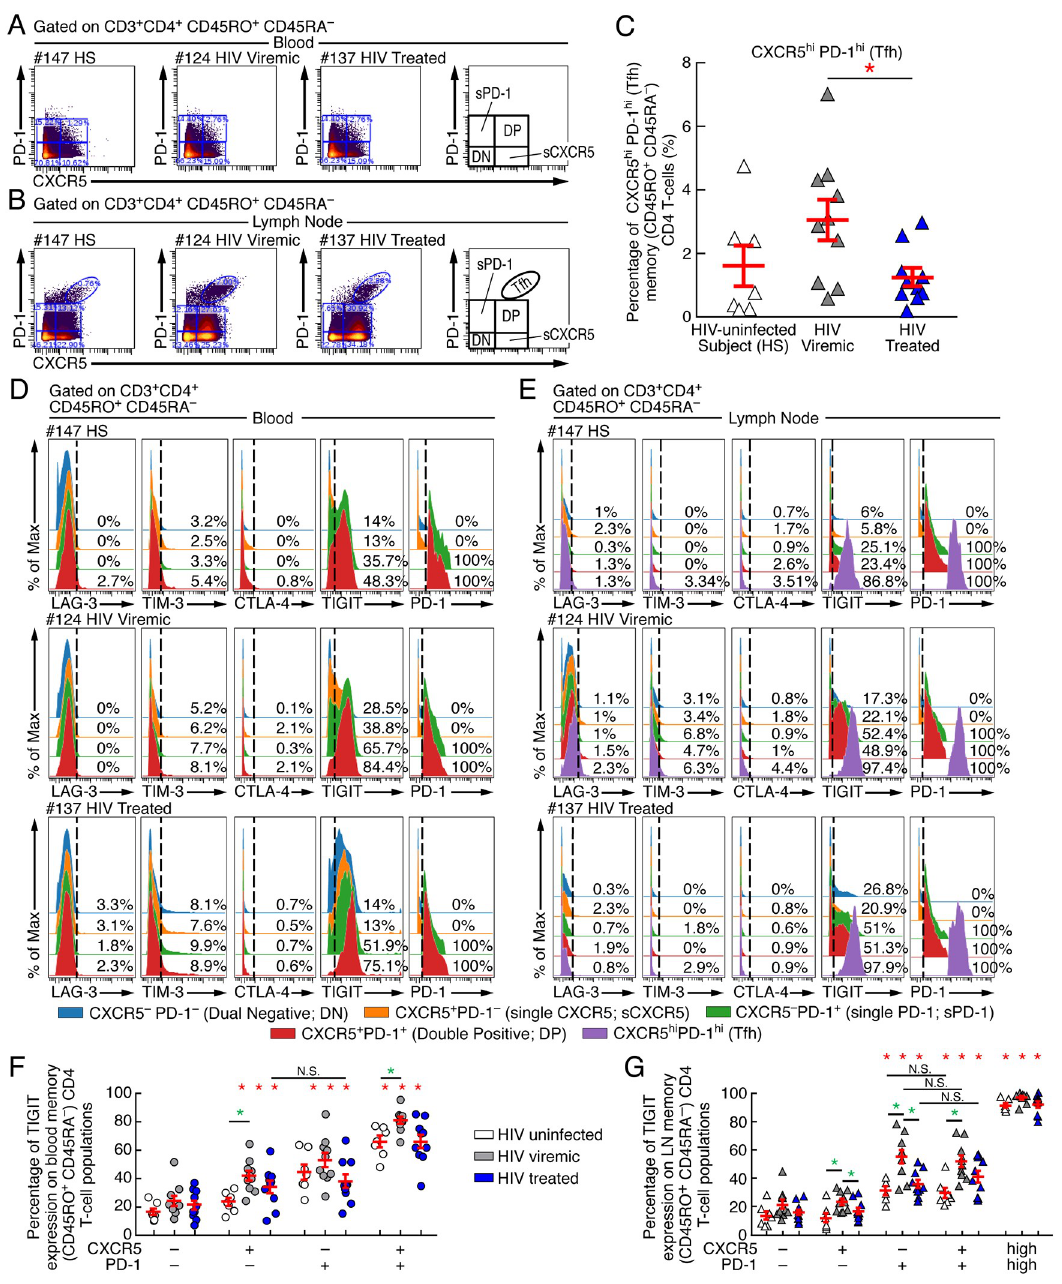
Fig 1. PD-1 and TIGIT are the two major ICs expressed on blood and LN memory CD4 T-cell populations including T- follicular helper cells. Representative mass cytometry profile of blood (A) and LN (B) memory (CD45RA - ) CD4 T-cell populations expressing CXCR5 and/or PD-1 of representative HIV-uninfected (#147), viremic (#124) and aviremic ART treated HIV-infected individual (#137). (C) Frequencies of LN CXCR5 high PD-1 high (Tfh) memory (CD45RA - ) CD4 T cells in HIV-uninfected (N = 7), viremic (N = 10) and aviremic ART treated HIV-infected individuals (N = 10). (D-E) Level of expression of LAG-3, TIM-3, CTLA-4, TIGIT and PD-1 on CXCR5 − PD-1 − (DN), CXCR5 − PD-1 + (single PD-1; sPD-1), CXCR5 + PD-1 − (single CXCR5; sCXCR5), CXCR5 + PD-1 + (Double positive; DP) and CXCR5 high PD-1 high (Tfh) memory CD4 T cell populations from blood (D) and LN (E) of one representative HIV-uninfected (#147), viremic (#124) and aviremic ART treated HIV-infected individual (#137). The dashed line corresponds to the cut-off of positivity of IC-molecule expression which was based on the expression on na ï ve (CD45RO - CD45RA + ) CD4 T cells (D-E) . Percentage of TIGIT expression on blood (F) and LN (G) memory (CD45RA - ) CD4 T-cell populations of HIV-uninfected (N = 7), viremic (N = 10) and aviremic ART treated HIV-infected individuals (N = 10). White symbols correspond to HIV-uninfected subjects, grey symbols corresponds to HIV-1 viremic individuals and blue symbols